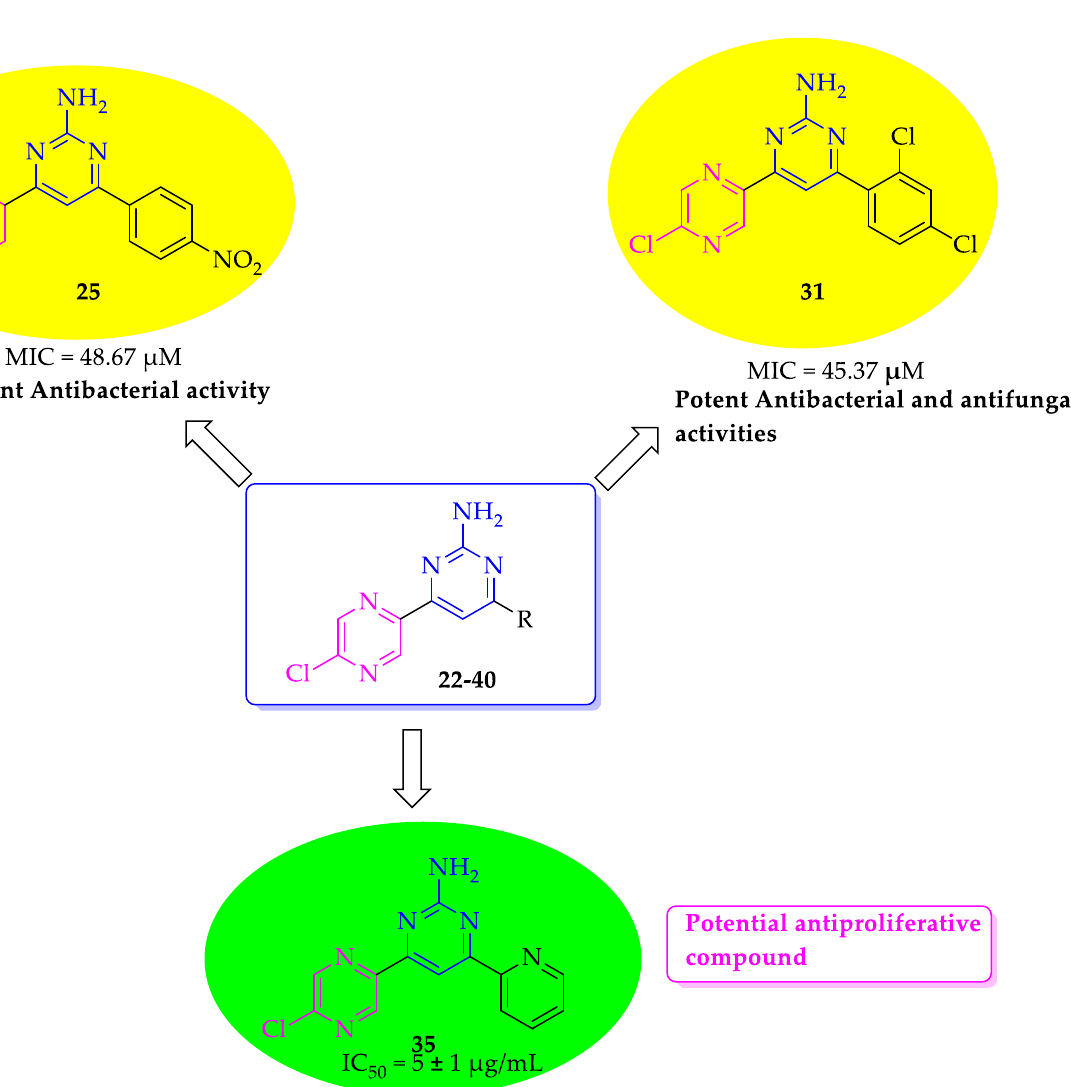
Figure 4. Structures of the most potent chloropyrazine-tethered pyrimidine